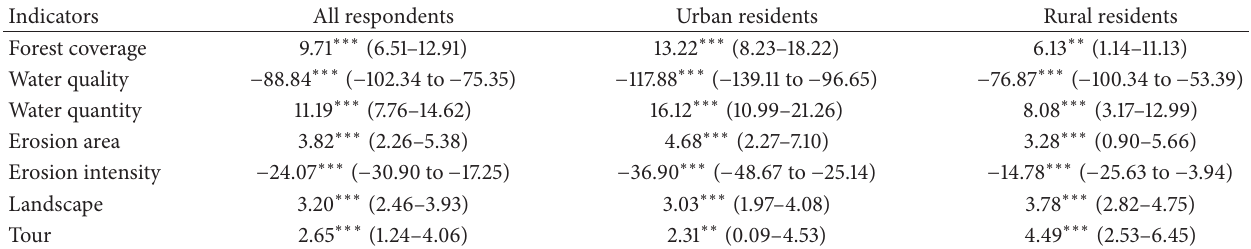
Table 7: Implicit prices of the mixed logit models and confidence intervals (95% level).